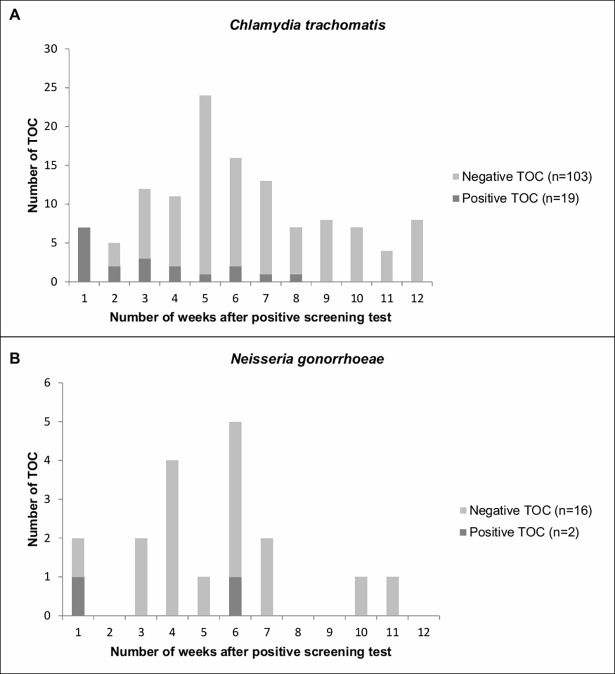
Distribution of the number of tests of cure and positivity per week.(A) The number of tests of cure per week for Chlamydia trachomatis based on the positive screening test (n = 622). Two tests of cure were performed in week 13, for clarity reasons these were added to week 12. (B) The number of tests of cure per week for Neisseria gonorrhoeae based on the positive screening test (n = 73). TOC, test of cure.